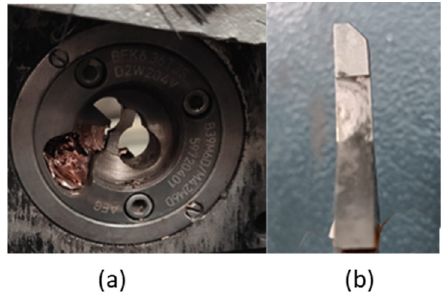
Figure 2. Typical defects of milling machines. ( a ) Milling machine covered by the chips from the electrodes. ( b ) Dull blade. electrodes. ( b ) Dull